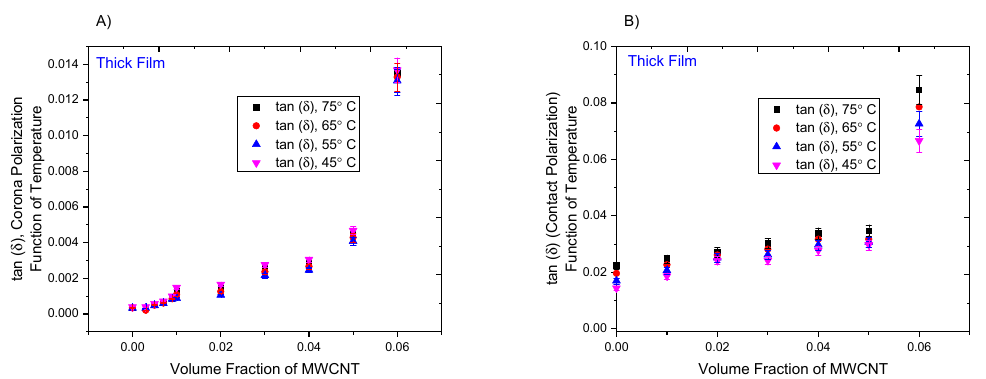
Figure 12. Dielectric loss, tan δ , of thick films as a function of polarization temperature and volume fraction of MWCNTs for ( A ) corona and ( B ) contact polarization conditions.